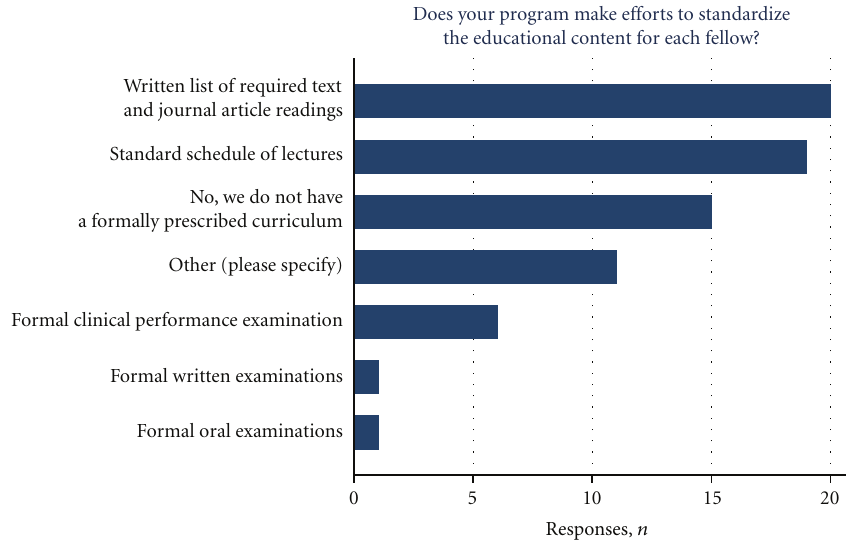
Figure 2: Responders describe efforts at standardizing educational content for each